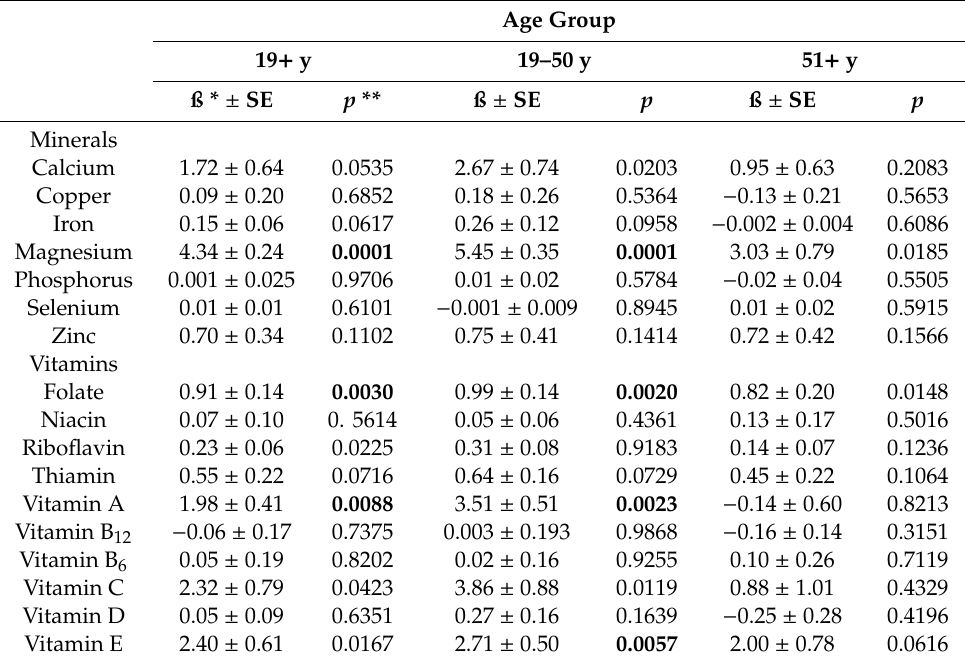
Table 4. Association between added sugars intake (% of calories) and percentage of adults 19 +